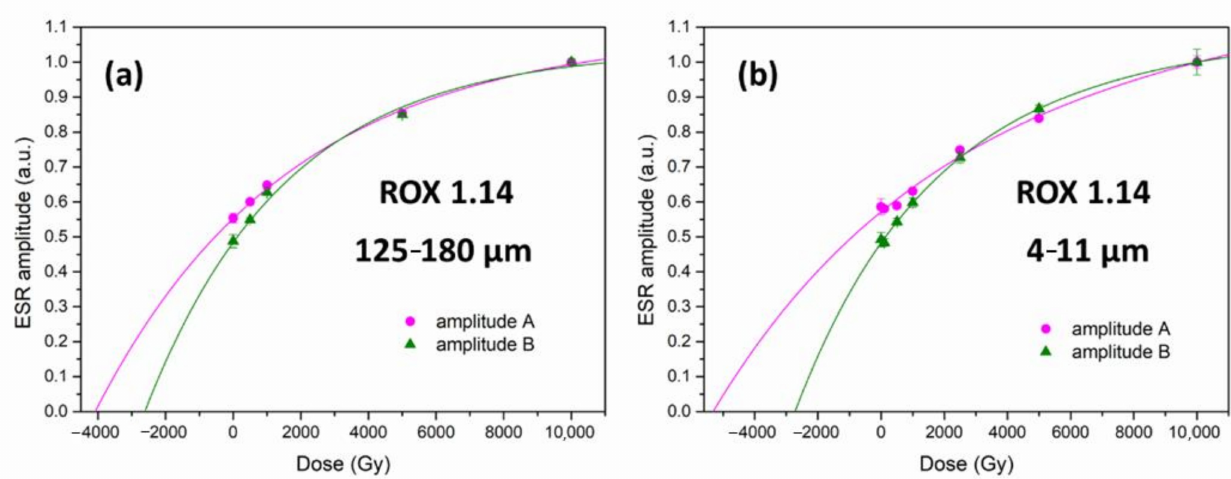
Figure 3. Dose response curves obtained for samples ROX 1.14 125–180 µ m ( a ) and 4–11 µ m ( b ) by measuring amplitudes A exp and B exp . Data normalised by the maximum value. Negative dose values indicate the dose accumulated in the material prior to laboratory